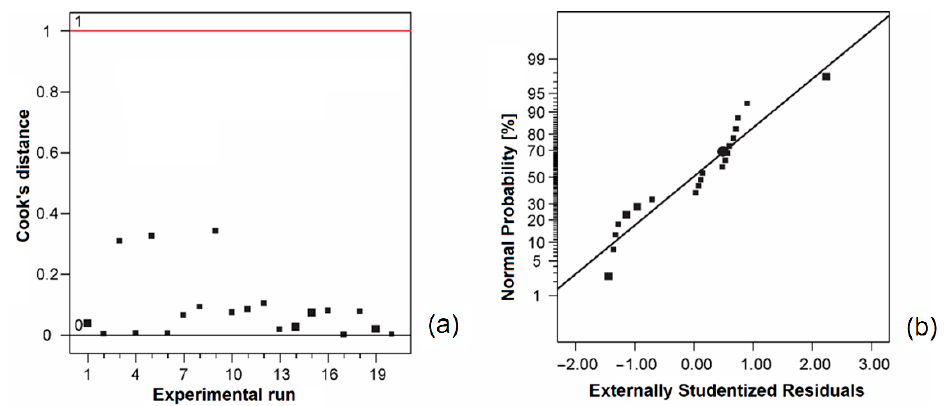
Figure 1. Cook’s distance ( a ) and normal distribution of residuals ( b ).